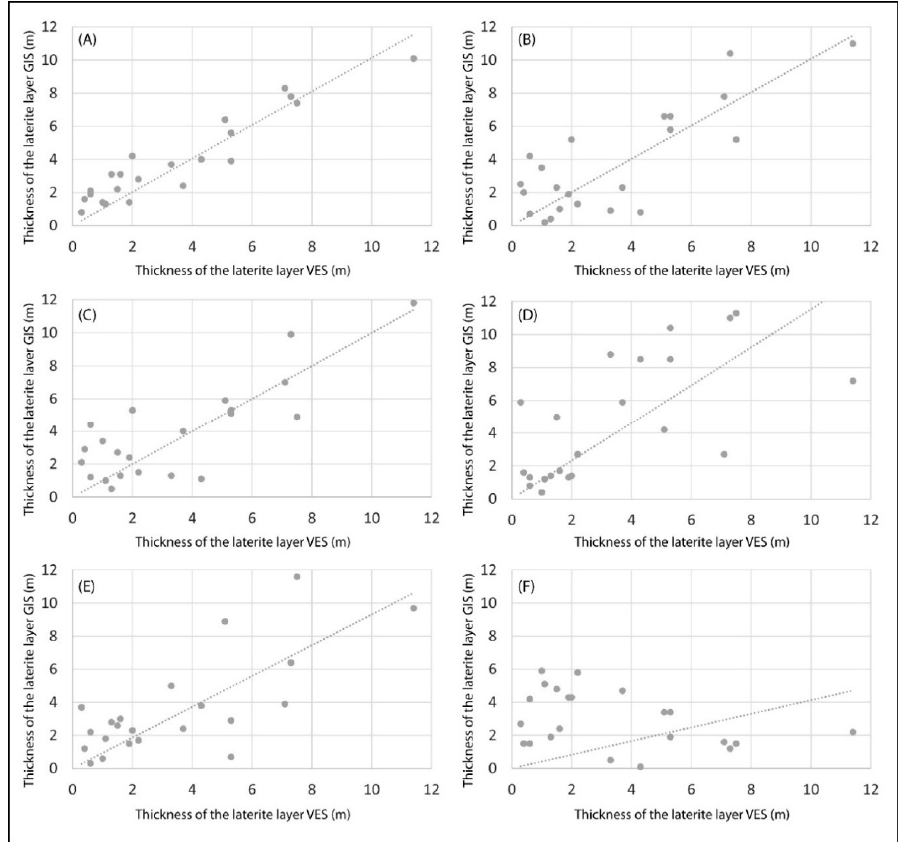
Figure 9. Calibration of the spatial distribution of subsurface geology: spatial database outcomes versus geophysical survey results. ( A ) Ordinary kriging; ( B ) minimum curvature; ( C ) radial basis function; ( D ) modified Shepard’s method; ( E ) inverse distance to power; ( F ) polynomial regression. VES: Vertical electrical sounding.